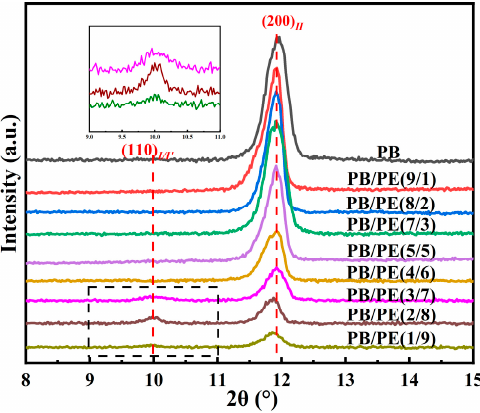
Figure 3. The X-ray diffraction (XRD) curves of PB and PB/PE blends obtained by cooling crystalli- zation.